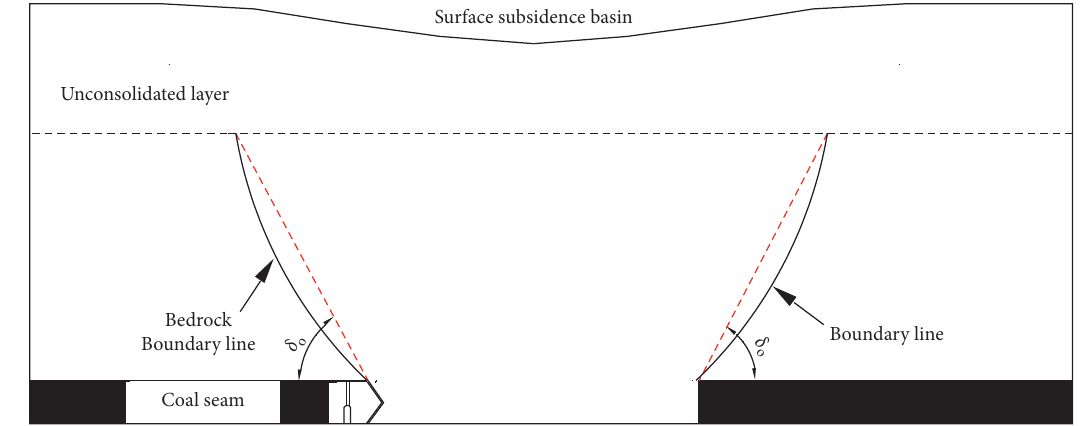
Figure 5: Movement boundary shape of bedrock.